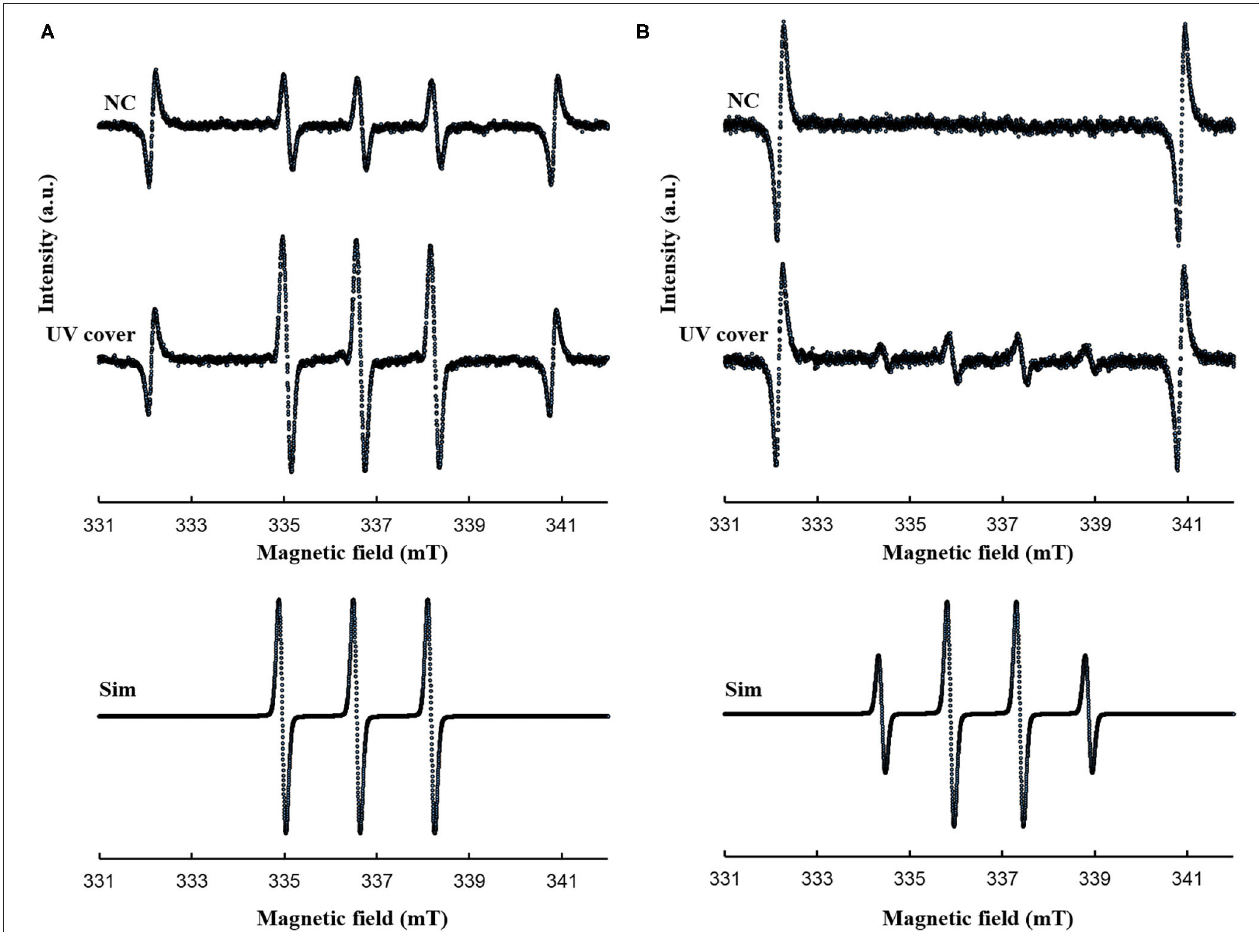
FIGURE 3 | ESR spectra for (A) TPC- 1 O 2 and (B) DMPO-OH. A 0.5mM DMPO or 0.5mM TPC solution was processed in each RVR condition (NC; negative control and UV cover mode) for 40 sec. Details of the ESR conditions are described in the methods section. Upper spectrum is NC and middle spectrum is UV cover condition. The lower spectra represent the simulated spectra of each adduct. Analyzed values are shown in Table 1 . Y-axis indicates intensity (arbitrary unit).